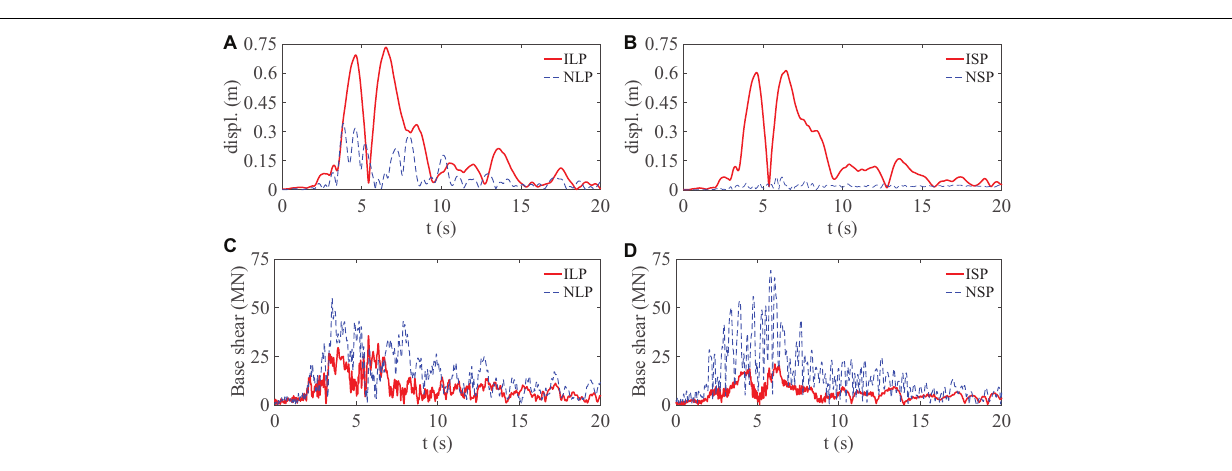
FIGURE 8 | Time history of the resultant responses of different bridge models under an NF record pair from the 1979 Imperial Valley earthquake: (A,B) the deck resultant displacement at the location of pier P 7 ; (C,D) the bridge resultant base-shear.